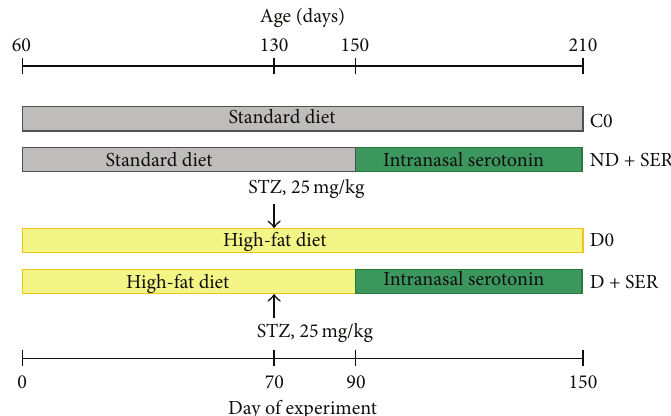
Figure 1: The design of HFD/low-dose STZ model of DM2 and the treatment of rats with intranasally administered